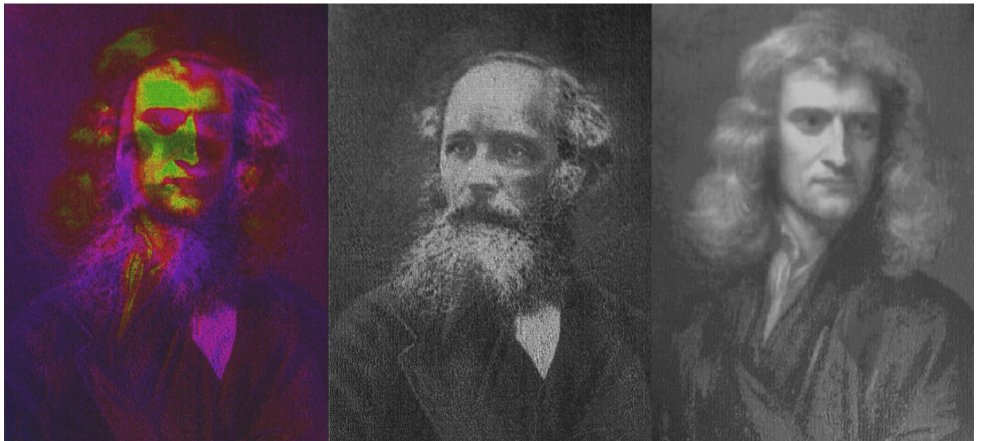
Figure 6. An image depicting encoding of information using type II modification induced birefrin- gence. While both of the images seem to be written in the same volume (image on the left ) images of Maxwell ( center ) and Newton ( right ) can be separated by exploiting imaging along both optical axes. Taken from